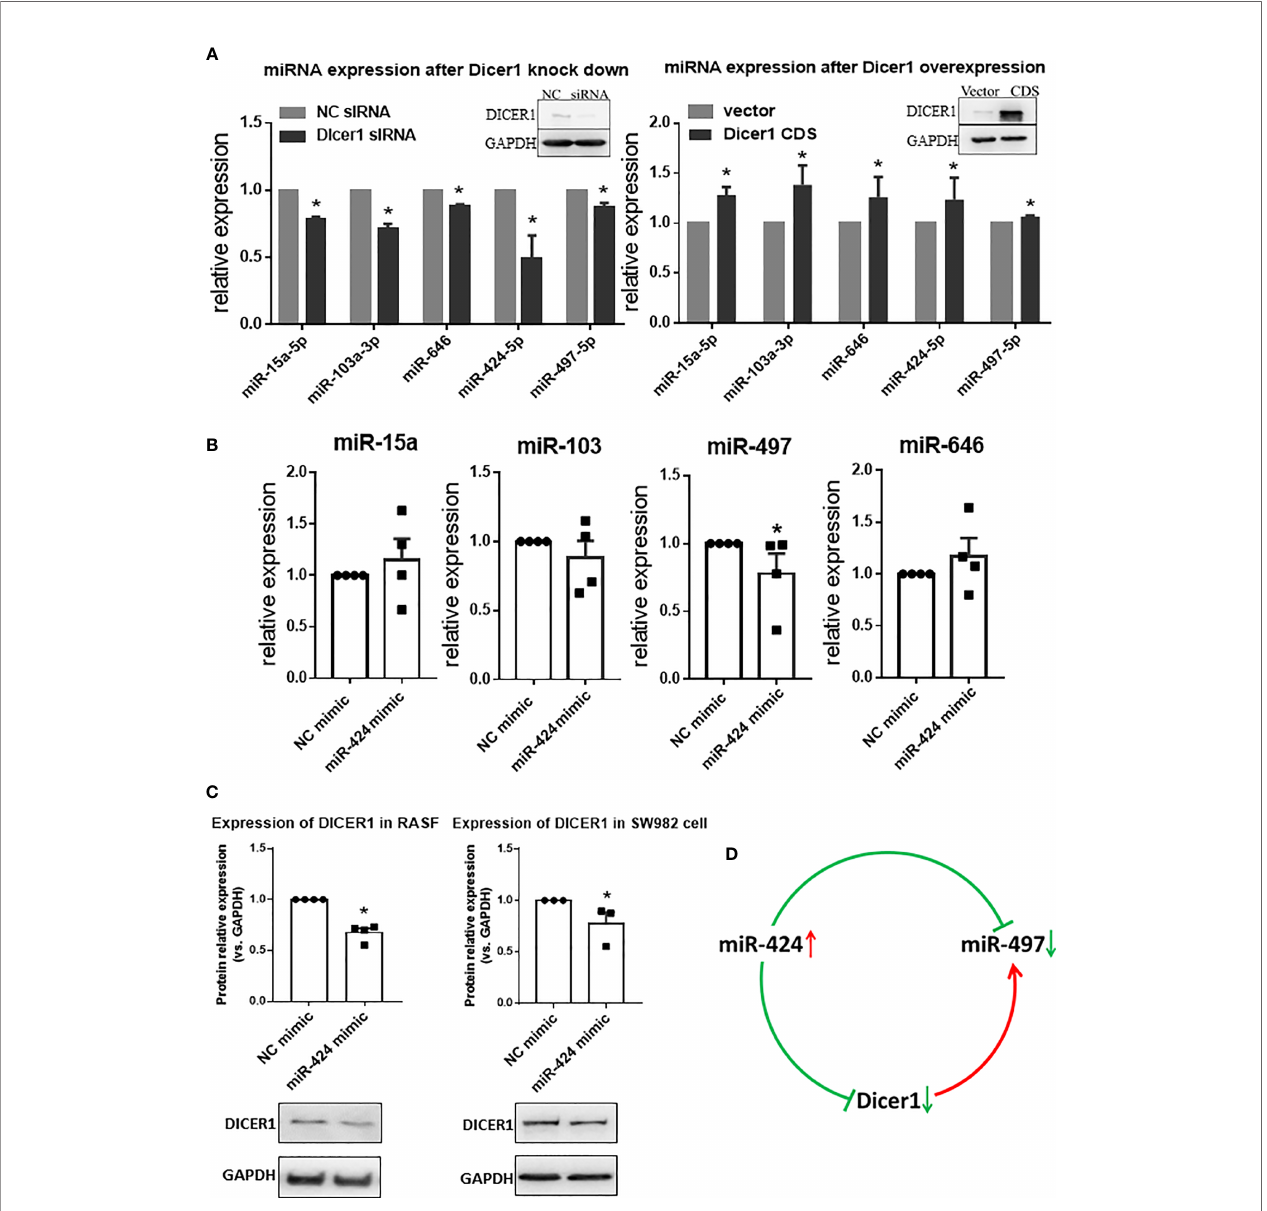
FIGURE 6 | Interaction of miR-424 and miR-497 with DICER1. (A) The expression of miR-15a, miR-103a, miR-424, miR-497 and miR-646 during loss and gain of DICER1 function in SW982 cells detected by RT-qPCR. Loss and gain of DICER1 function were validated by western blotting, representative image shown. (B) The expression of miR-15a, miR-103, miR-497 and miR-646 after transfected with 10 nM miR-424 mimic for 48 h by RT-qPCR in RASF. (C) Western blotting results of DICER1 after transfected with 10 nM miR-424 mimic for 48 h in RASF and SW982 cells. (D) Brief mechanism diagram of negative feedback loop. RASF cells were isolated from synovial tissue of 4 RA patients. Bar: mean ±SEM from 4 patients in RASF and mean ± SEM from 3 independent cell experiments in SW982 cell. Triplicates were used for each transfection and RT-qPCR experiment. *: P <0.05 compared with